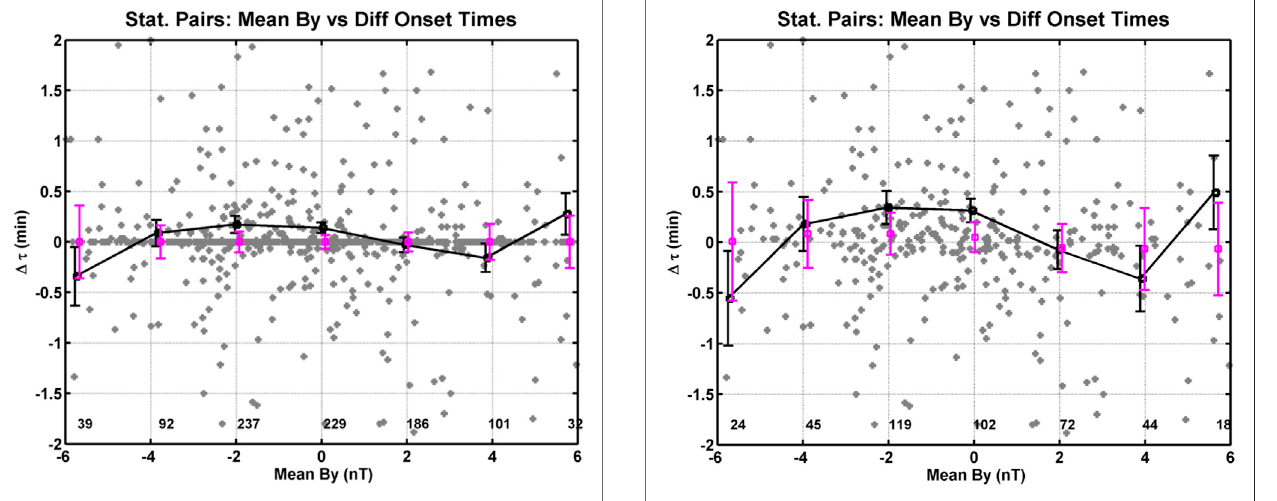
Frontiers in Astronomy and Space Sciences |